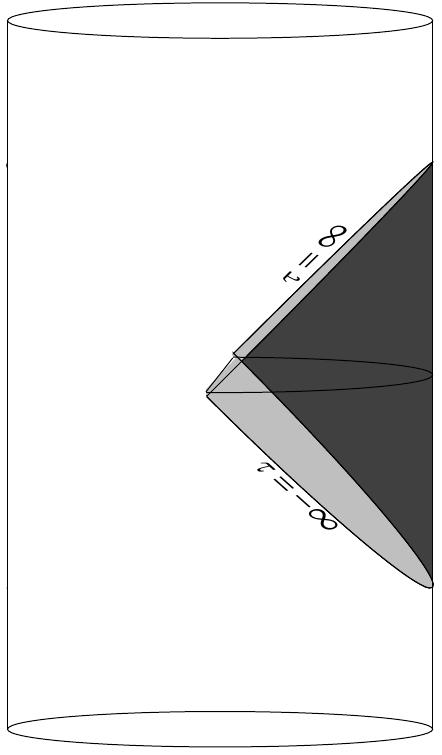
Figure 4: AdS / Rindler